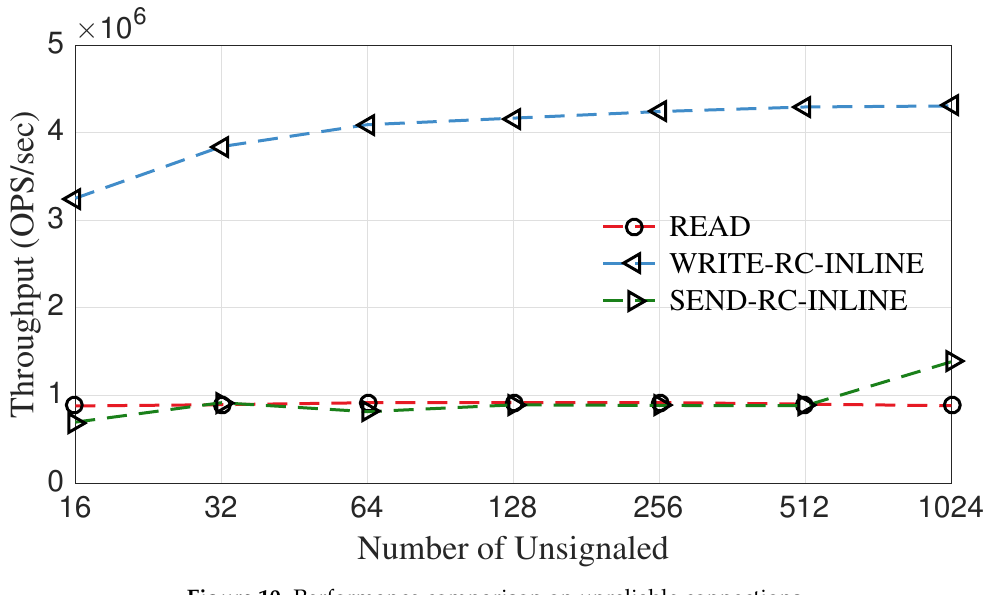
Figure 10. Performance comparison on unreliable connections.